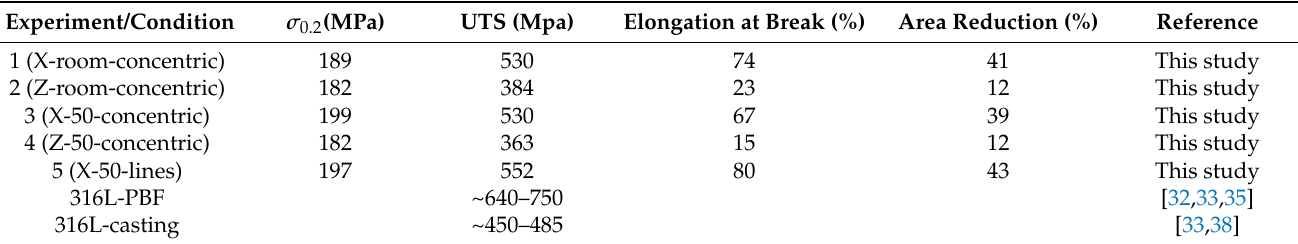
Table 4. Elastic modulus, yield strength ( σ 0.2 ), ultimate tensile strength, elongation and area reduction mean values for each of the conditions.